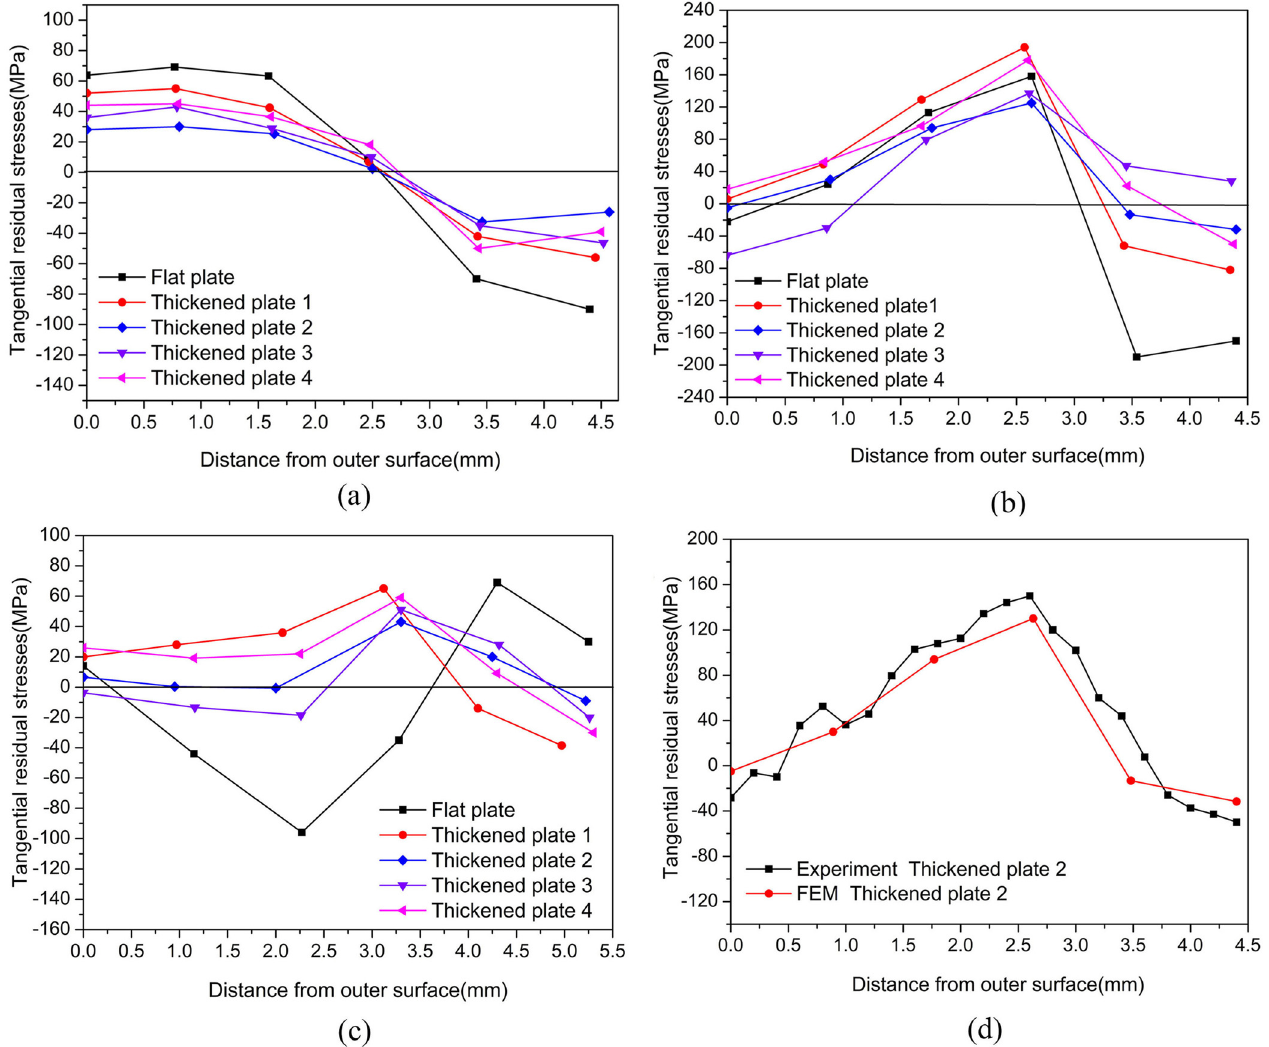
Fig. 14. The comparisons of residual stresses of thickened plates and fl at plates of (a) cup bottom, (b) cup wall and (c) die entrance radius of square cups, and (d) comparison of the residual stresses in the cup wall obtained from numerical simulations and experimental